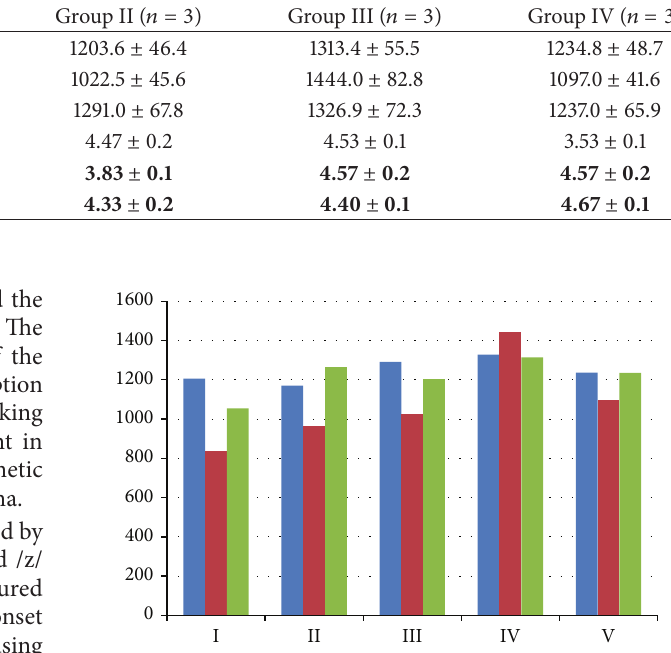
Table 1: Comparison between the studied groups according to sounds measured by the maximum energy (frequency, HZ). Sounds